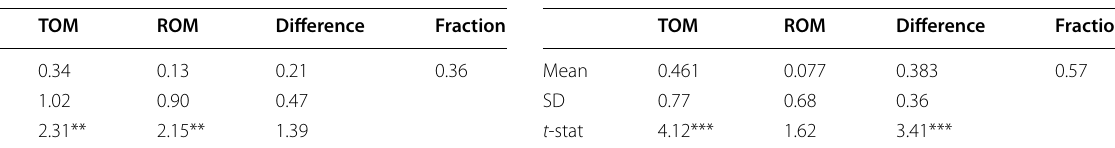
Table 3 T-test of means for “Turn-of-the-Month-Effect” of year 2013